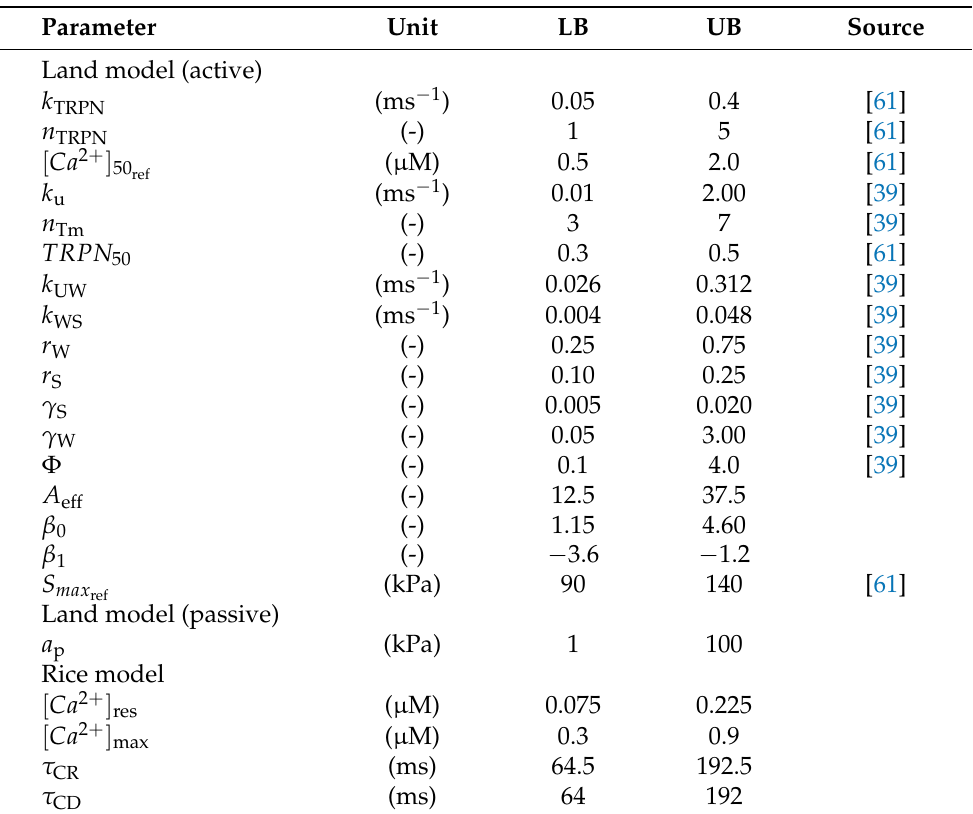
Table A5. Parameter bounds used in this study. Lower bounds are denoted by LB and upper bounds are denoted by UB. If applicable, the source is